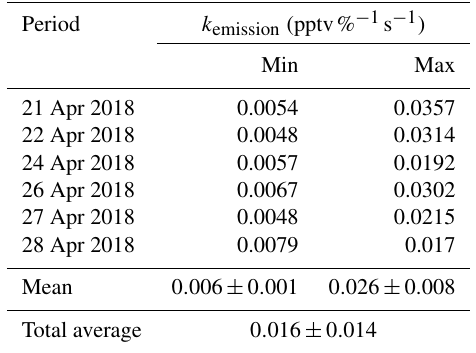
Table 4. Summary of the temporary HONO emission rate from dew water, k emission , from 19 to 29 April 2018.